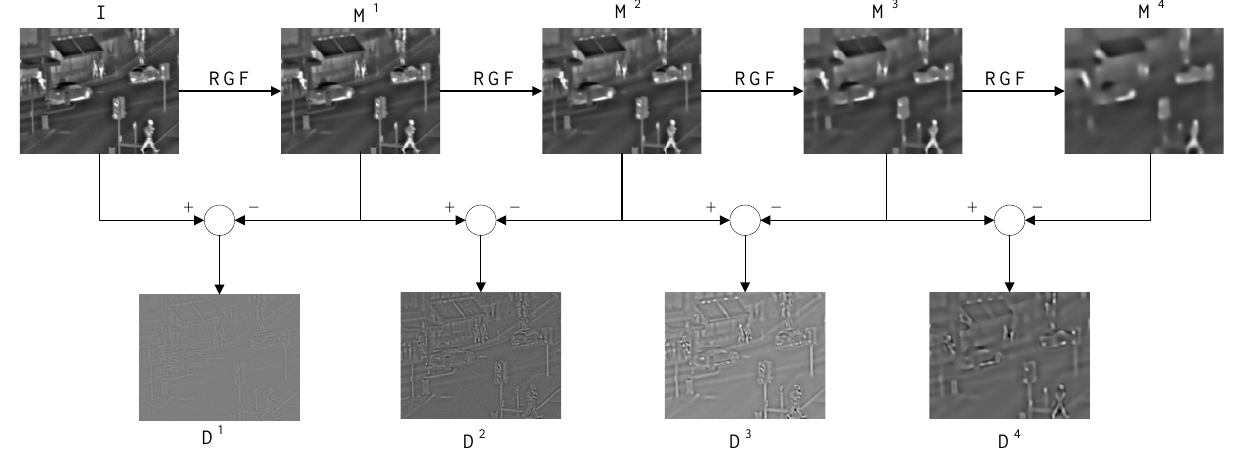
Figure 4. Image multi-scale decomposition